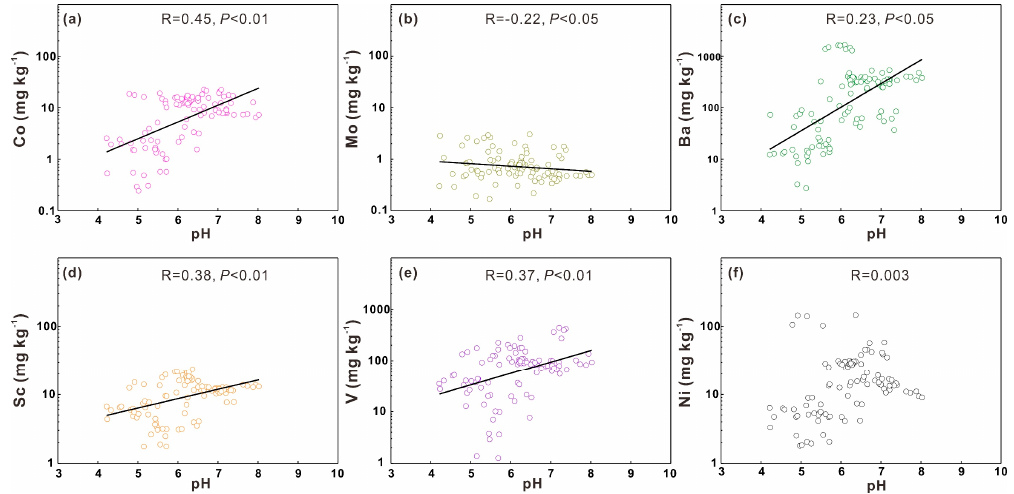
Figure 6. Linear correlation between soil pH and the heavy metals Co ( a ), Mo ( b ), Ba ( c ), Sc ( d ), V ( e ), Ni ( f ).